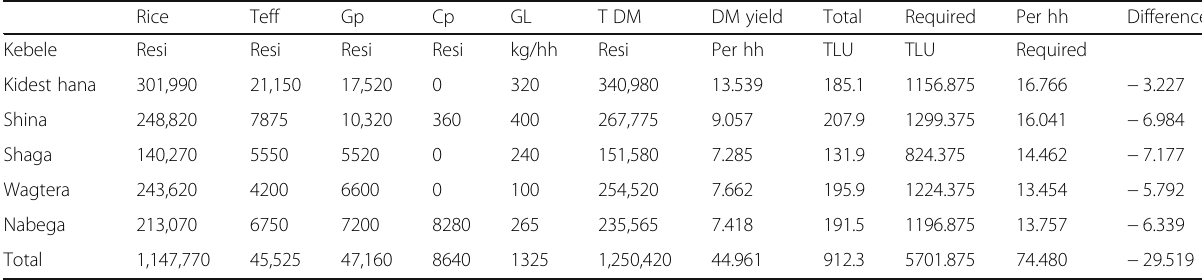
Table 3 Animal feed supply and requirement in tons of dry matter (DM) Rice